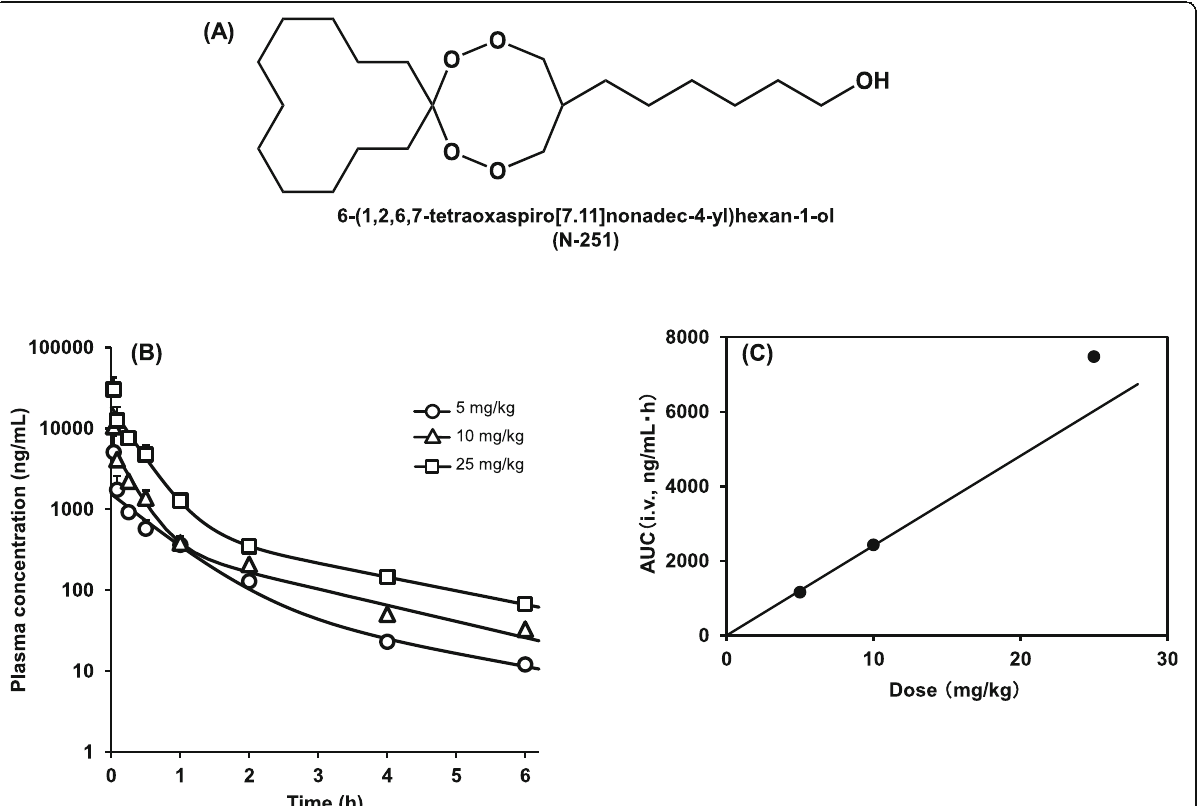
Fig. 1 Structure of N-251 ( a ) and dose dependency of the pharmacokinetics of N-251 after intravenous in mice ( b ) and the correlation between dose and AUC i.v ( c ). Results were expressed as mean with the bar showing the SD value. The solid lines are theoretical lines obtained in the fitting